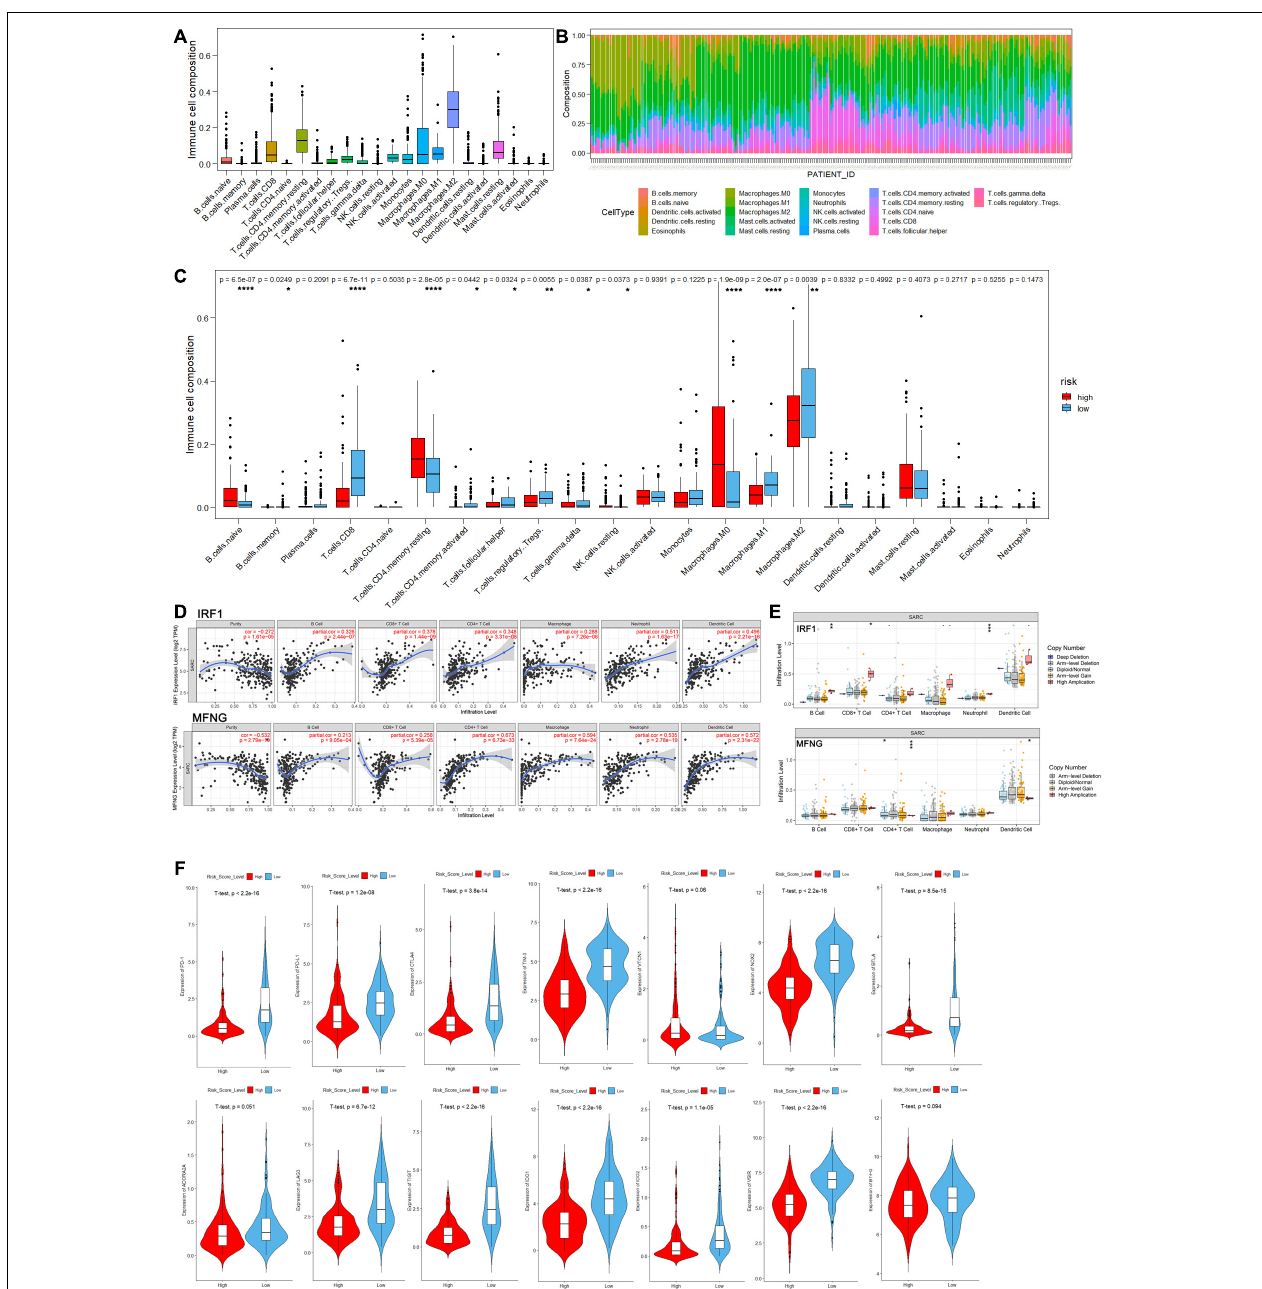
FIGURE 9 | The landscape of immune cell infiltration in the high- and low-risk score groups of sarcoma patients by analysis of CIBERSORT. (A) Distribution proportion of each type of immune cell infiltration in all patients. (B) Relative proportion of immune cell infiltration in each sarcoma patient. (C) Bar plot visualizing significantly differentially infiltrated immune cells between high- and low-risk score group patients. (D,E) Correlation between immune cell infiltration and gene expression/mutation levels of IRF1 and MFNG analyzed by the TIMER database. (F) Violin plots of log-scaled normalized expression of inhibitory immune checkpoints between high and low risk